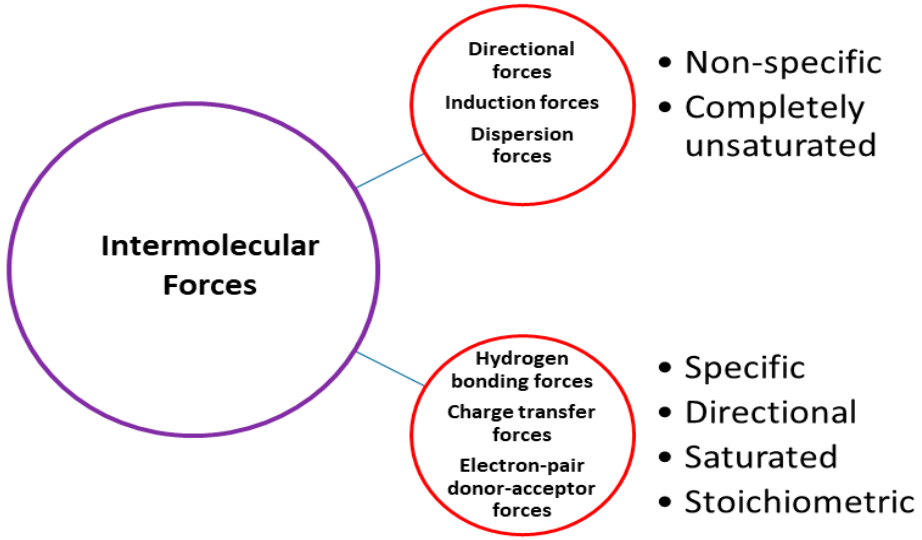
Figure 12. Types and characteristics of intermolecular forces.